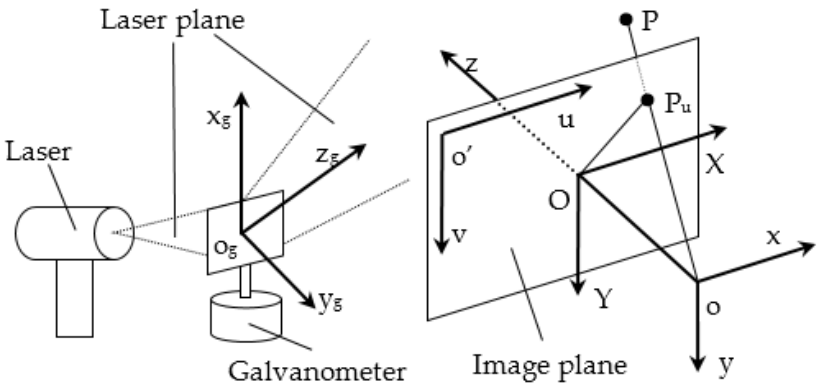
Figure 2. The schematic for system coordinate system setup.